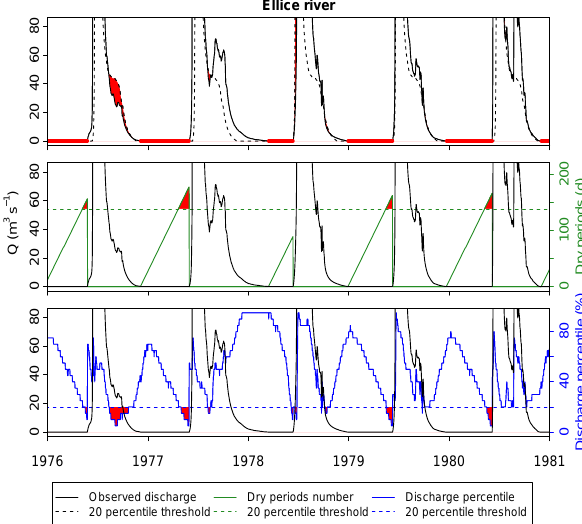
Fig. 9. Drought events (indicated in red) identified by the differ- ent methods for the Ellice River. The upper panel gives the TLM. Discharge values are shown as solid black line. The dashed line is the calculated threshold (20th percentile). The middle panel gives drought events calculated with the CDPM; the consecutive dry pe- riods are indicated by the green line, and droughts are identified if periods exceed the threshold (dashed green line). When combining these methods, the discharge is converted to percentile values (low- est panel, blue solid line). If the percentile value drops below or equals the 20% (dashed blue) line, the month is in drought.